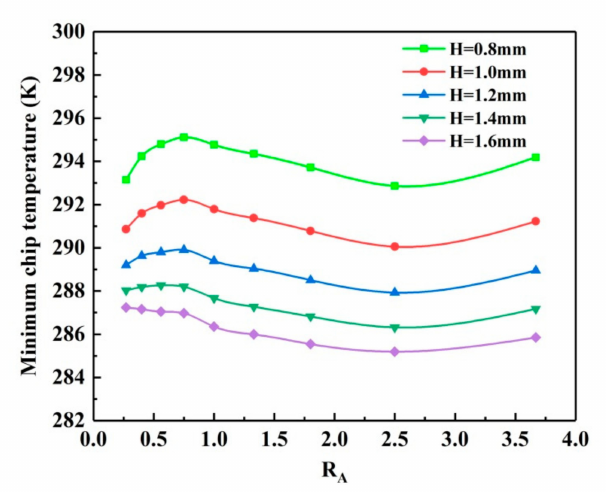
Figure 8. Variation of the minimum chip temperature with cross-sectional area ratios of the cold to hot ends of the legs for di ff erent